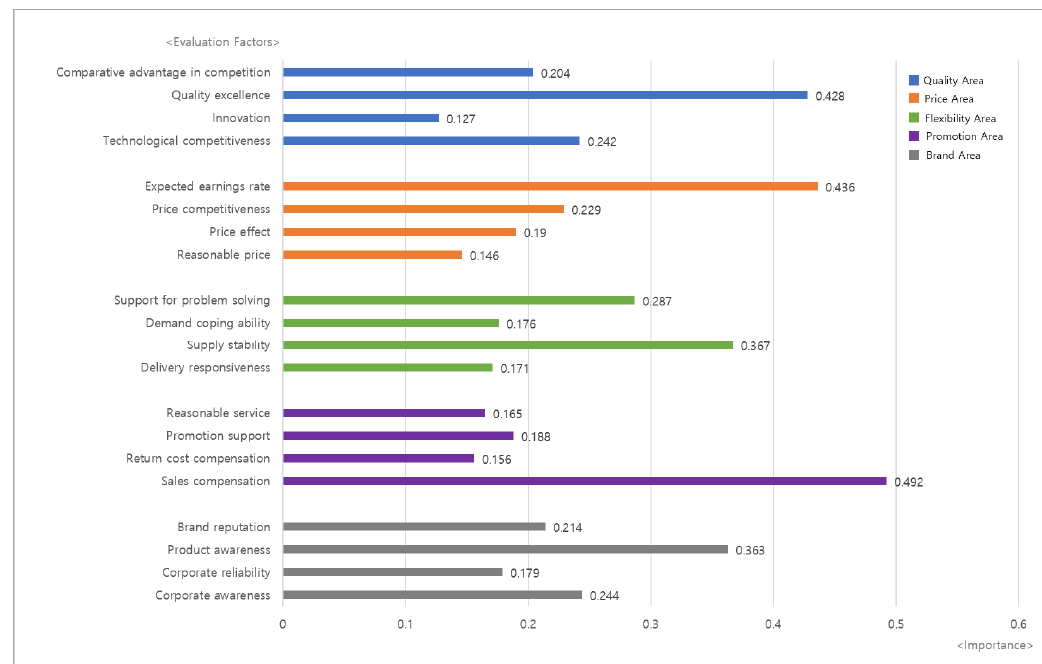
Figure 3. Weight analysis result of evaluation factors by areas.